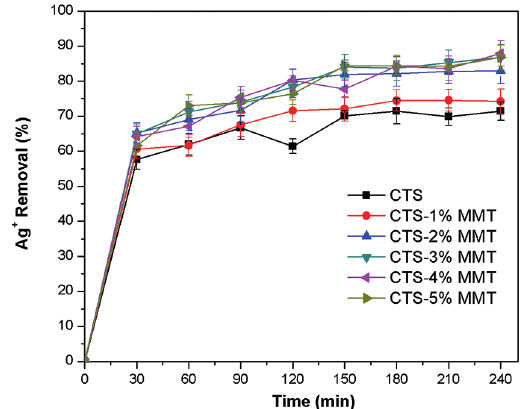
Figure 4: Effects of contact time and MMT concentration in bead on Ag + removal (adsorbent dosage: 1 g; Ag + concentration: 10 mg/L; volume: 100 mL; pH: 7).